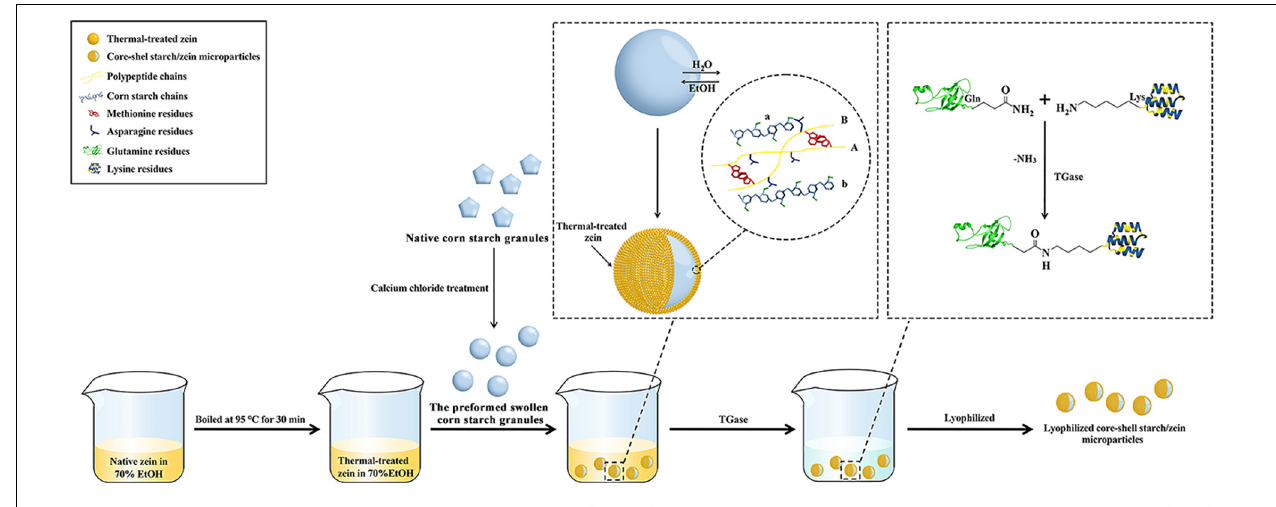
FIGURE 1 | A scheme of the fabrication of core-shell starch/zein microparticles accessed by using antisolvent exchange and protein